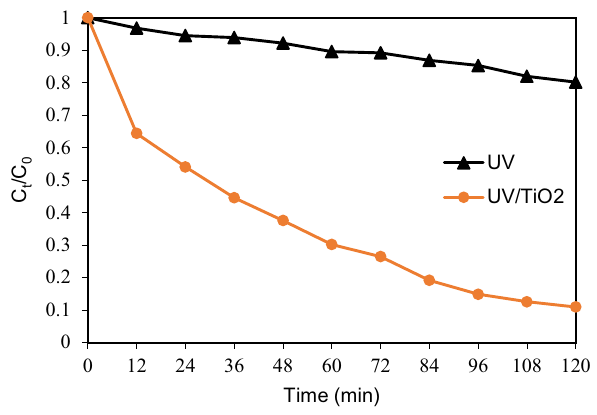
C 2 /β-SiC foam ( RhB = 10 ppm,